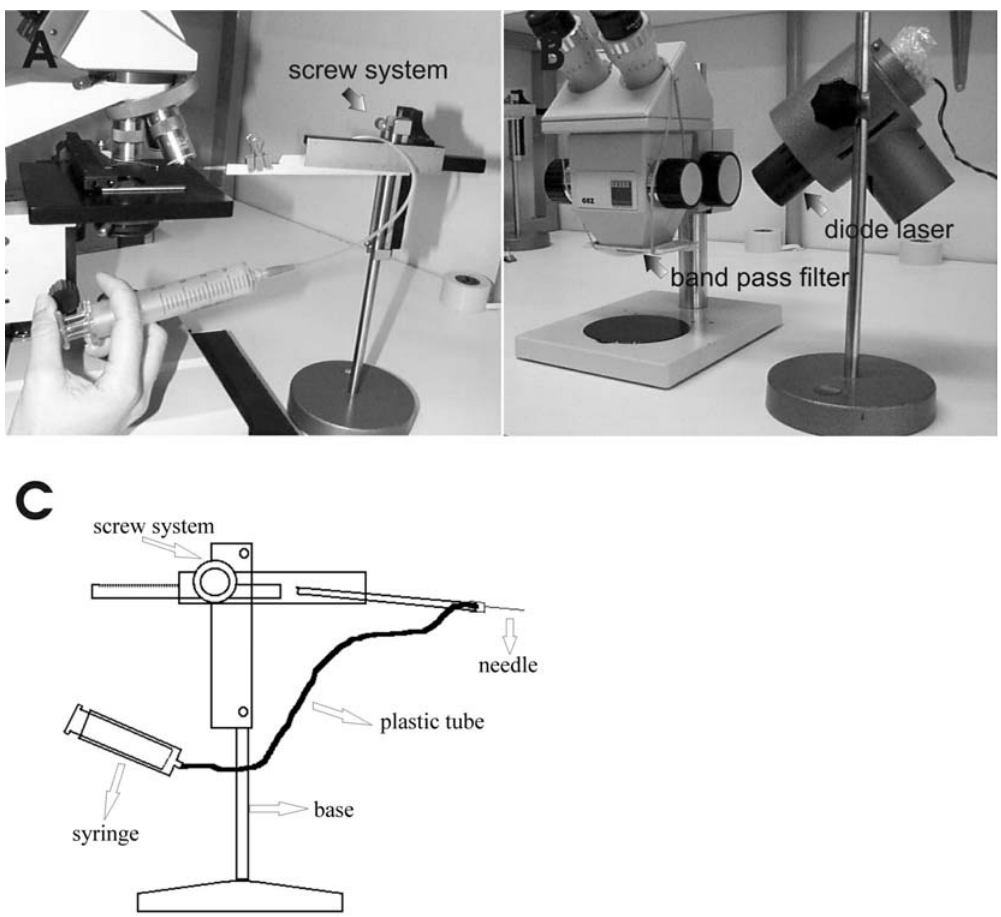
Figure1 -A:Micro-manipulationapparatusbasedonamechanicalmicroscopestage.B:Stereo-microscopewithaband-passfilteraddedtotheobjective lens and a laser diode. C: Diagram of the main parts of the micro-manipulation